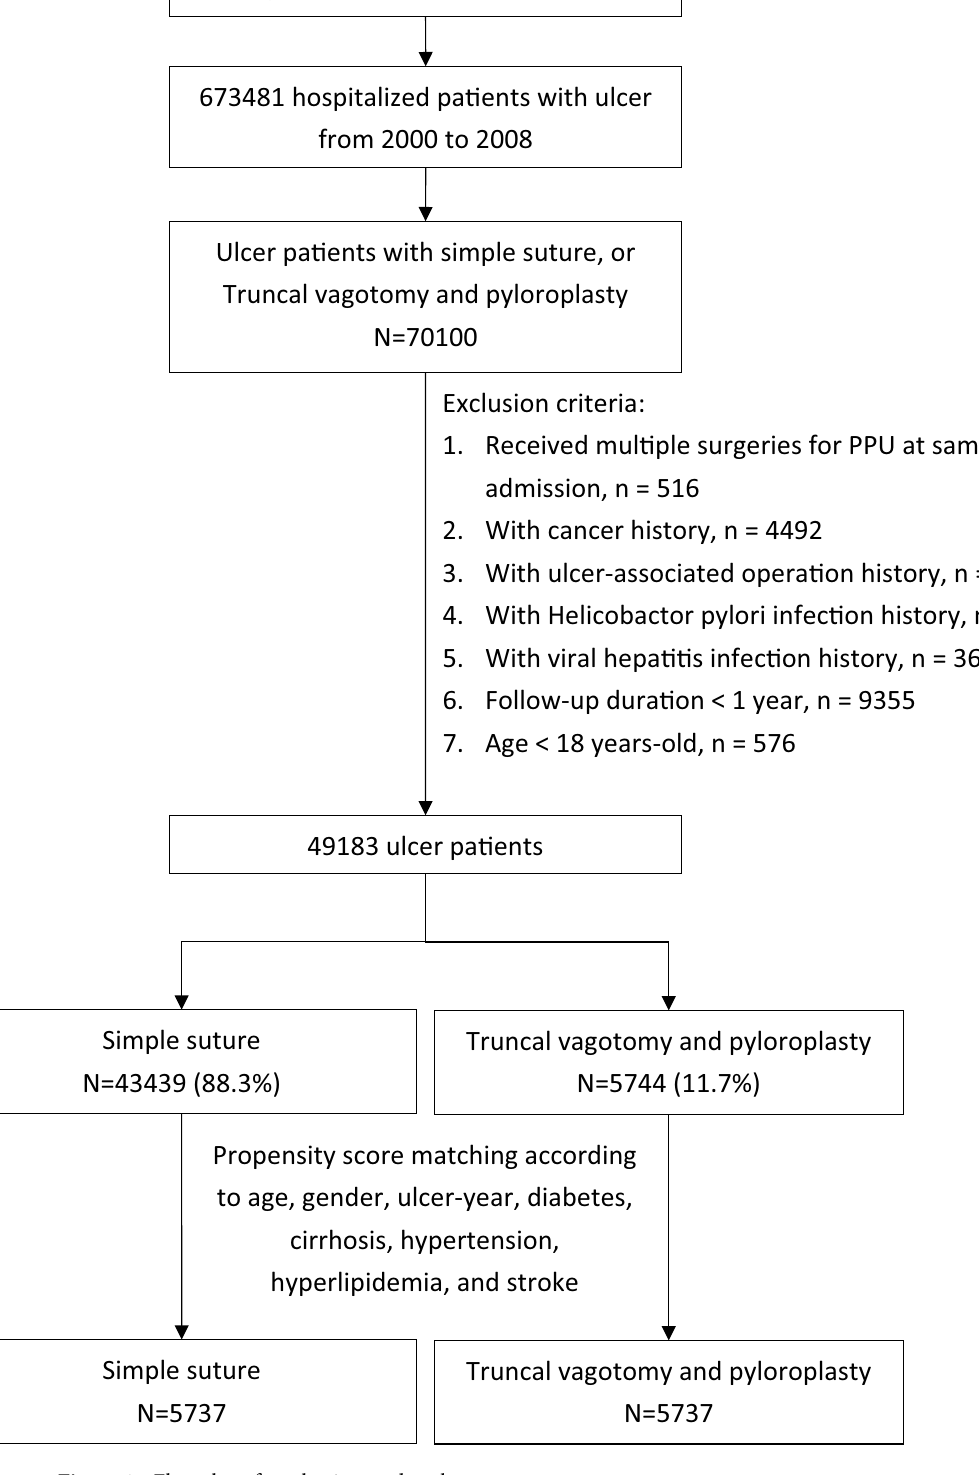
Figure 1. Flow chart for selecting study